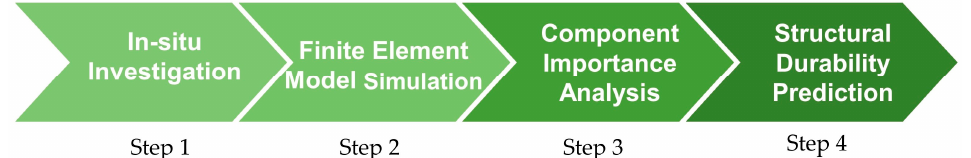
Figure 1. The procedures of the durability prediction method for historical RC